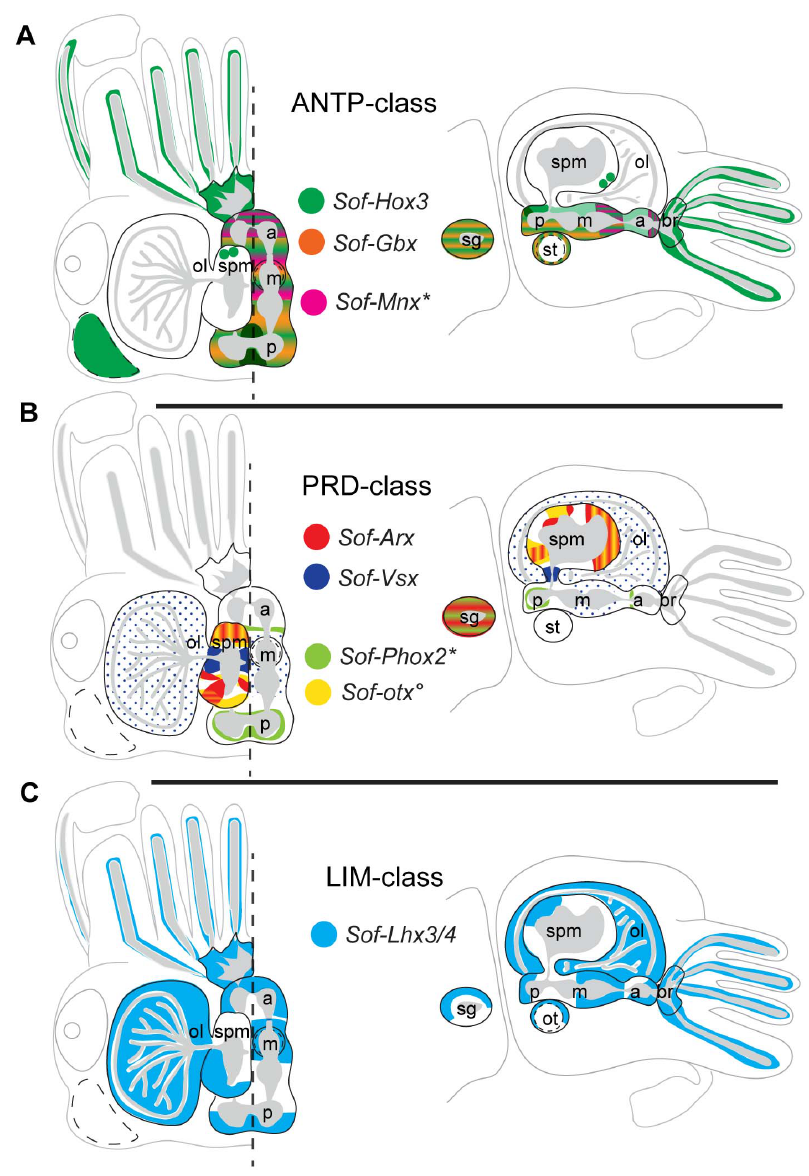
Figure 6. Schematic representation of HD gene expression domains in the cuttlefish CNS. Expression territories are extrapolated from analysis of serially sectioned embryos from stages E24–28 (this paper) and previously published data * u . Dorsal view of the head is shown on the left, and lateral view on the right as in Figure 1. Territories with potentially overlapping expression domains are multi-coloured. A) ANTP-class Hox genes Sof-Hox3 (dark green), Sof-Gbx (orange), and Sof-Mnx* (pink). B) PRD-class genes Sof-Arx (red), Sof-Vsx (dark blue), Sof-Phox2* (light green), and Sof-otx u (yellow). C) LIM-class gene Sof-Lhx3/4 (light blue). Note that ANTP-class genes are largely restricted to the subesophageal masses, whereas PRD-class genes are more expansive within the supraesophageal mass. Both Sof-Hox3 and Sof-Lhx3/4 show extensive expression throughout the nervous system, and five of the eight genes represented here are found within the stellate ganglion. Abbreviations are as in Figure 1; * data extrapolated from Nomaksteinsky et al . [26] for stage E29 embryos; u data extrapolated from Buresi et al. [25] for embryos at stages E25–26.